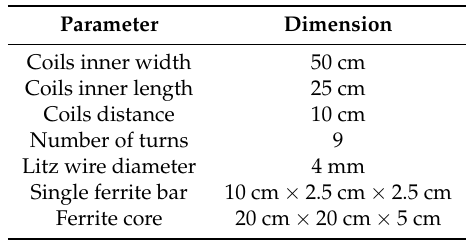
Table 2. Dimensions of the original (full-scale) IPT (inductive power transfer) system.